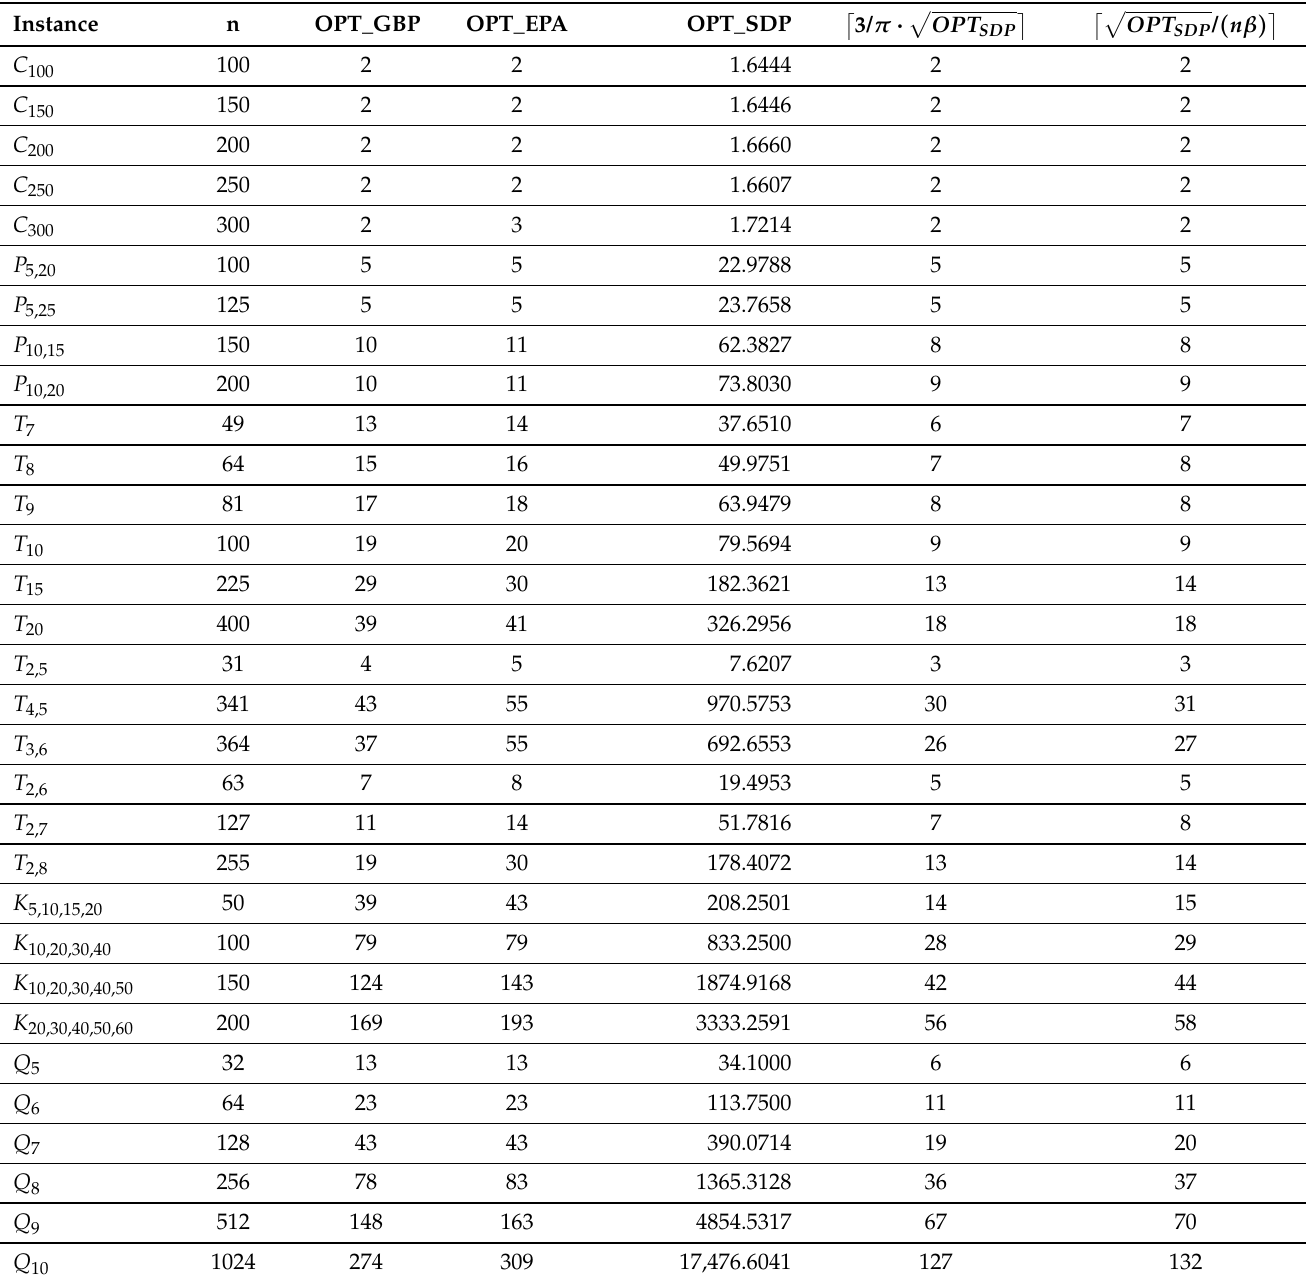
Table 3. Results on graphs with a known